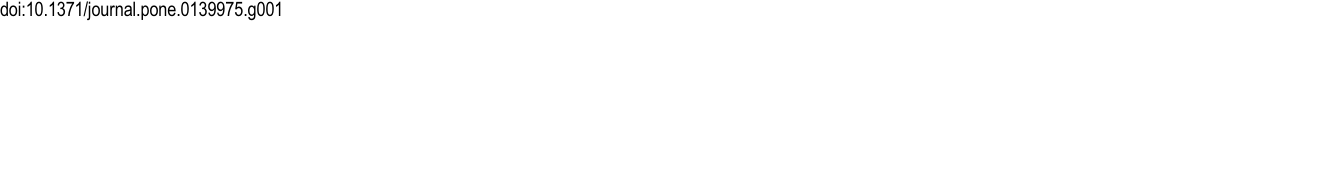
Fig 1. the effect of different methods of adjustment on results of observational analyses in comparison to the randomized design result. The dotted line indicates the concordance boundary (hazard ratio for randomized design ± 0.15).